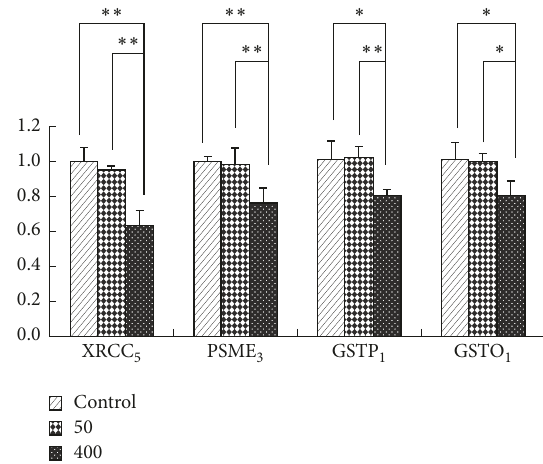
Figure 4: Effect of elaidic acid on XRCC 5 , PSME 3 , GSTP 1 , and GSTO 1 mRNA expression. ∗ indicated a significant difference ( 𝑝 < 0.05 ), ∗∗ indicated a significant difference ( 𝑝 < 0.01 ).